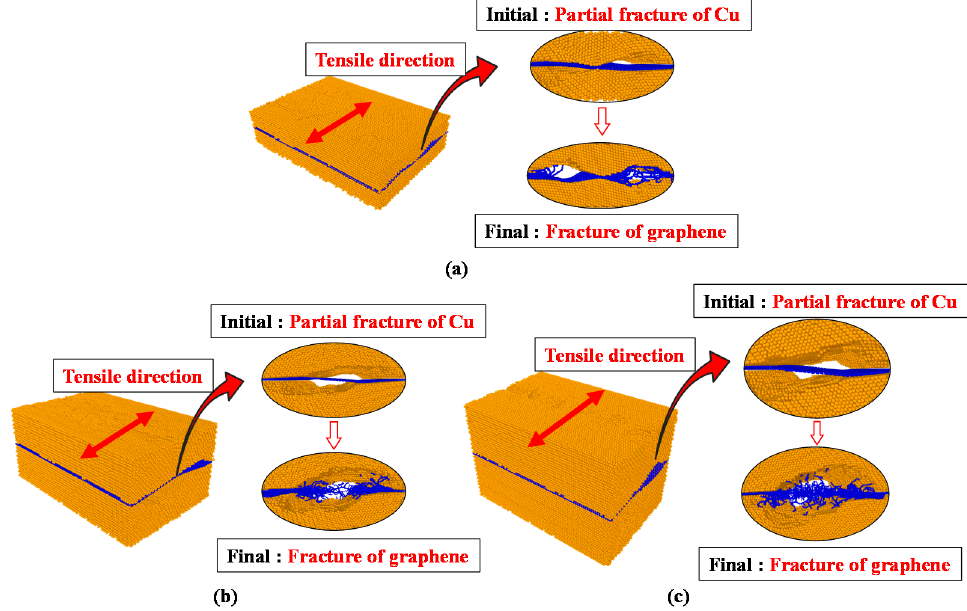
Figure 7. Fracture phenomenon with respect to the armchair direction. ( a ) Model A; ( b ) model B; ( c ) model C.